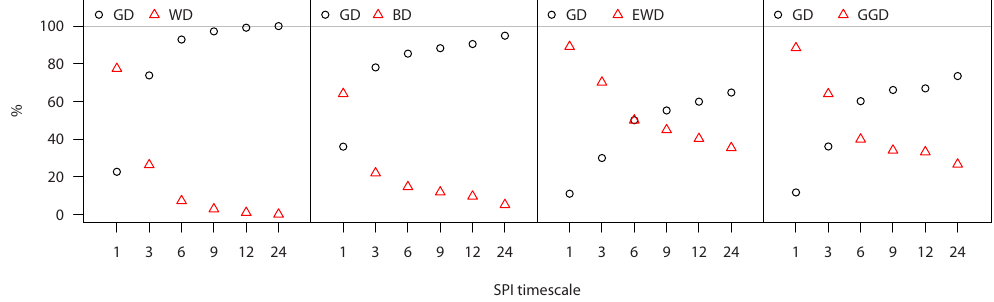
triangles) in dependence of the SPI time scale.